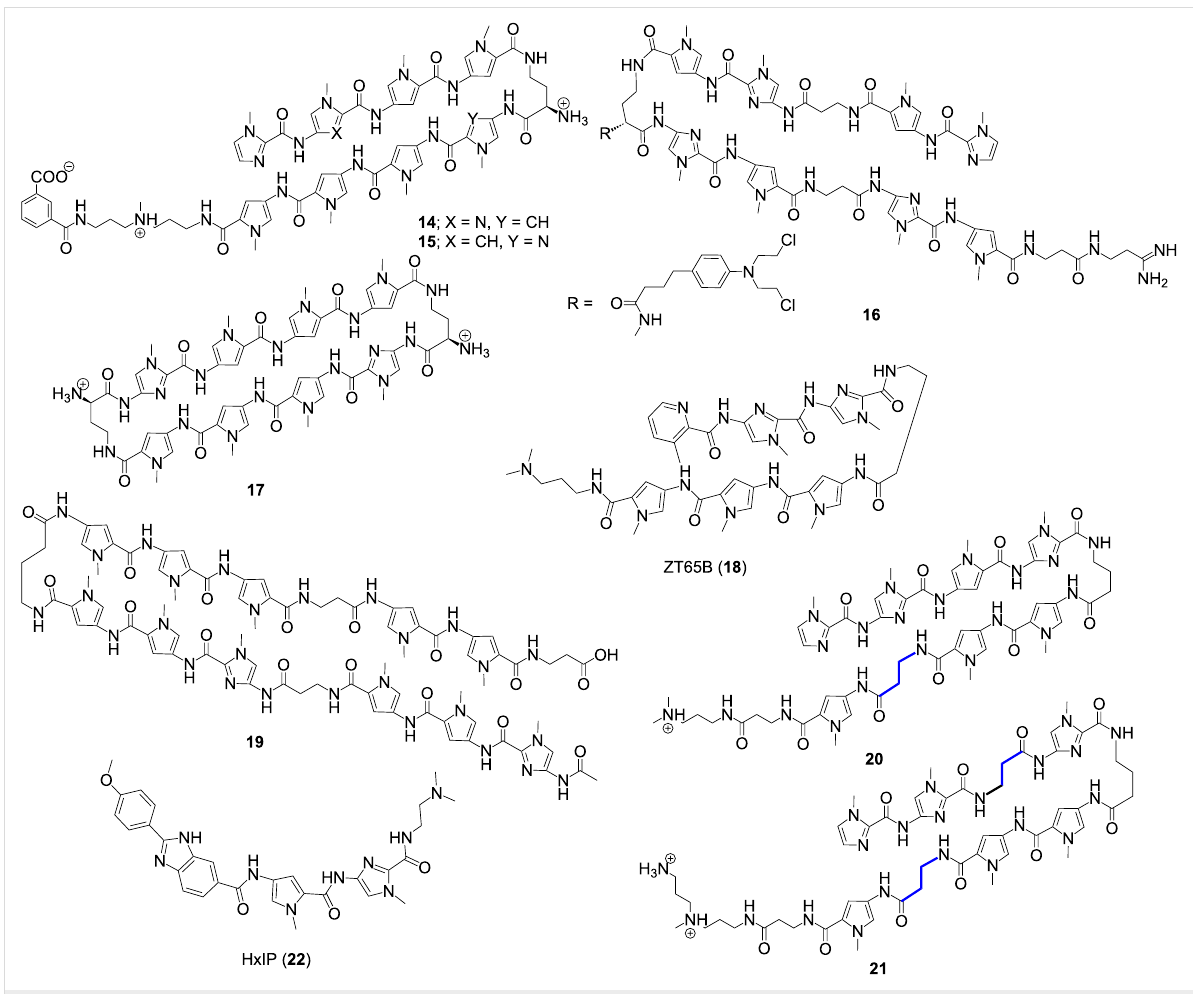
Figure 6: Chemical structures of synthetic “hairpin” pyrrole–imidazole (Py/Im) conjugates.